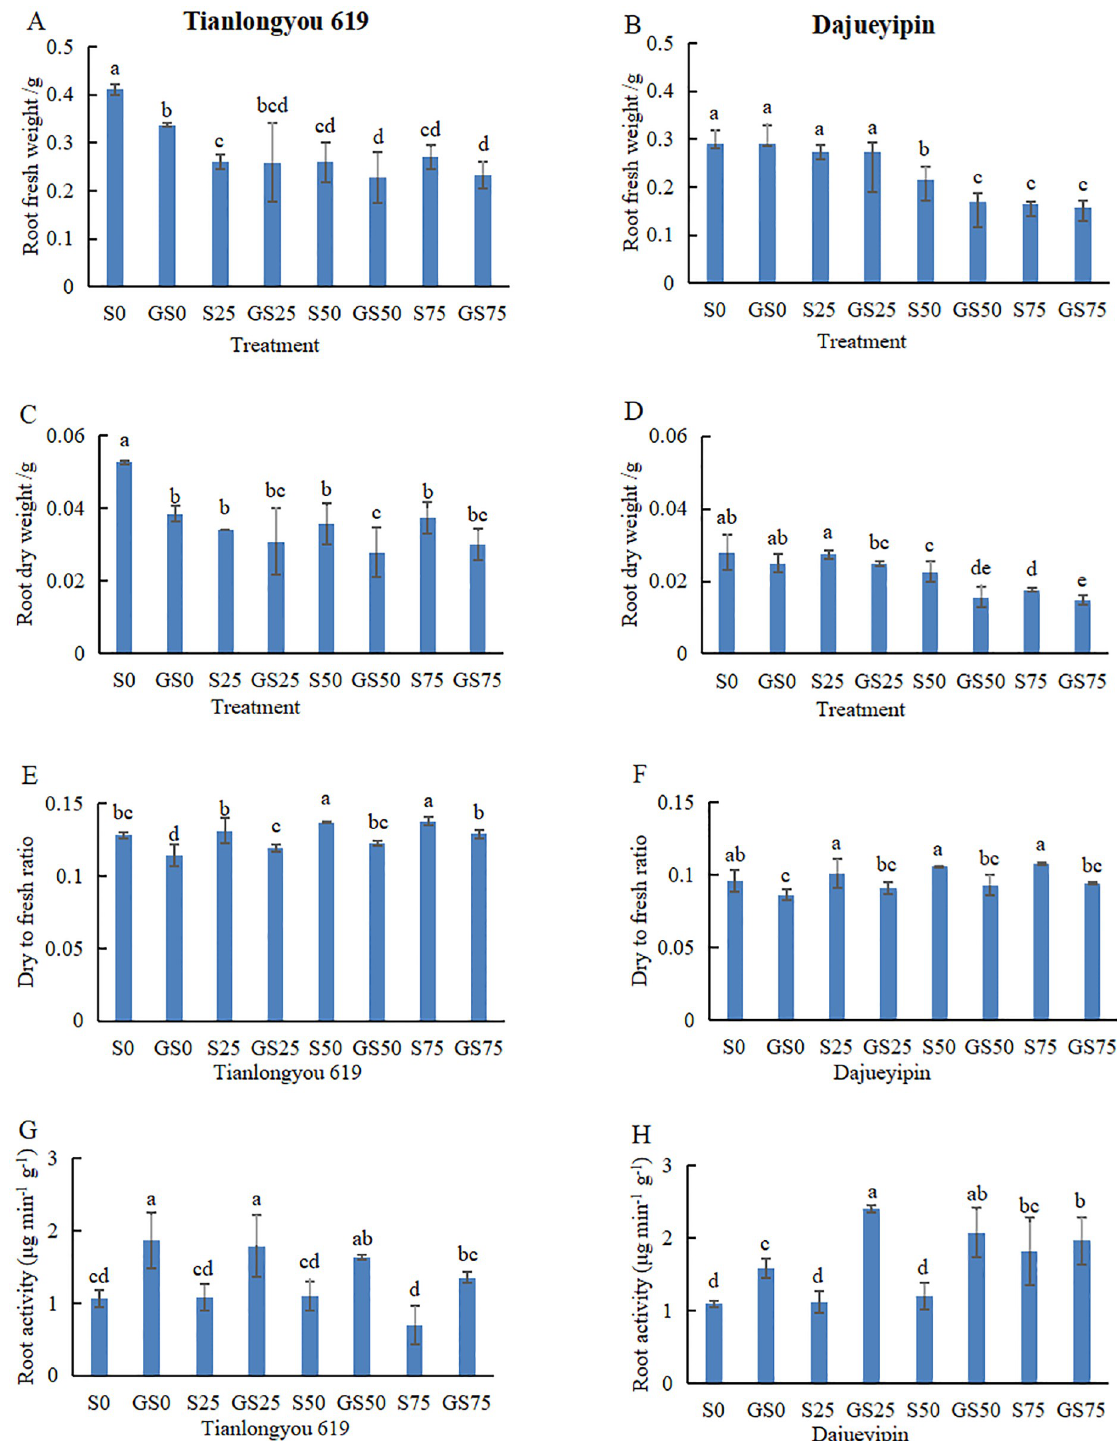
Fig 3. Assessment of root growth on two rice varieties under different salt or/and GABA treatments.